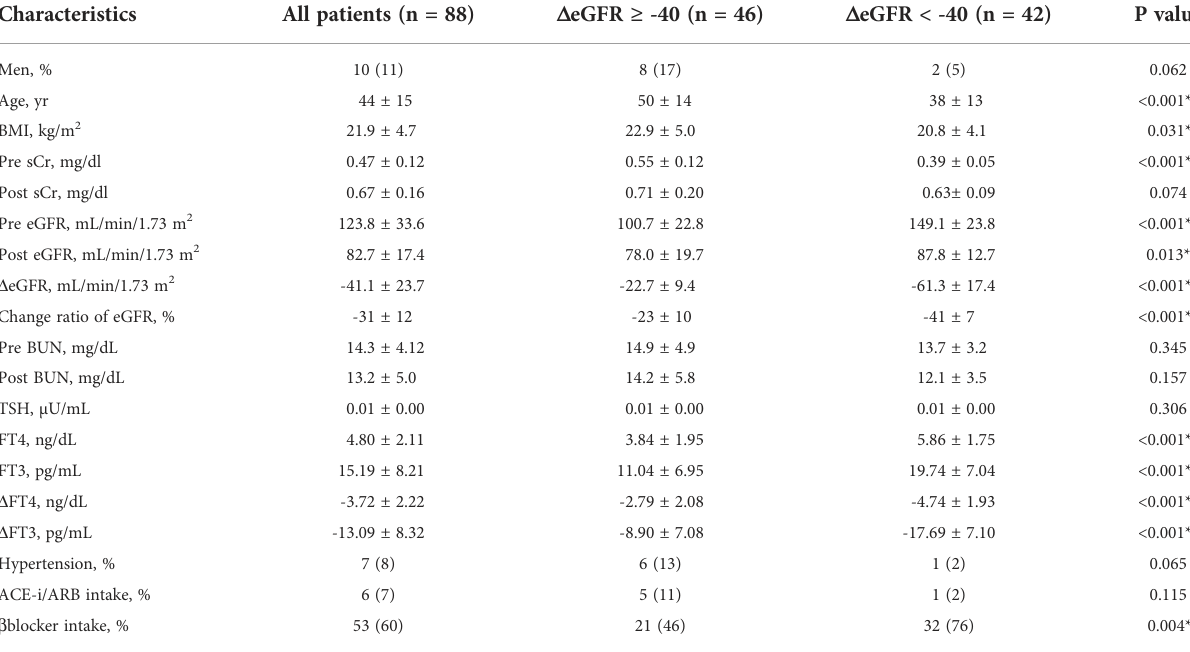
TABLE 2 Characteristics of study participants divided by D eGFR (<-40 and ≥ -40) in hyperthyroidism.